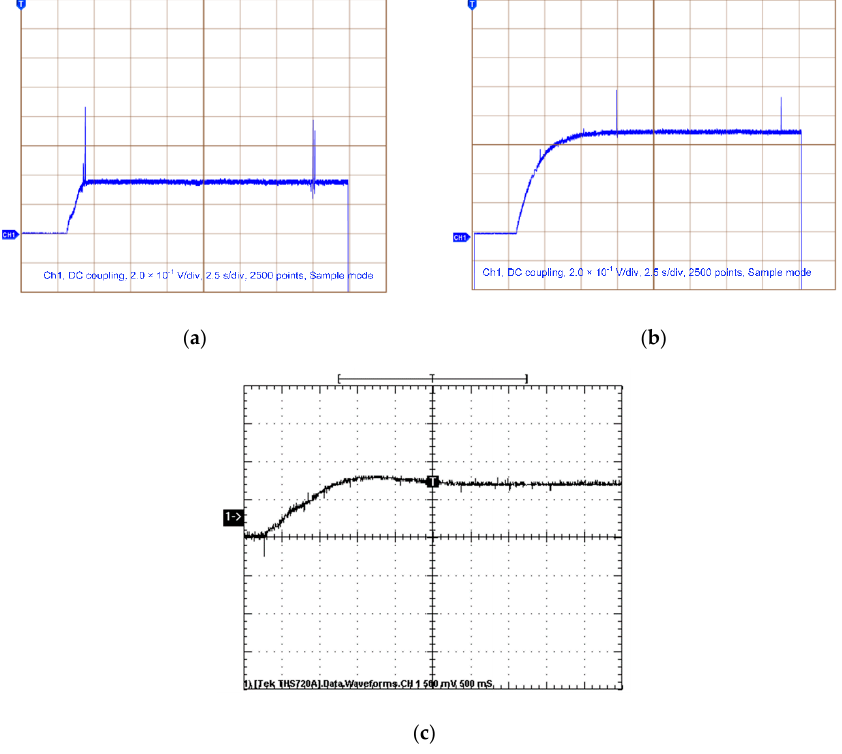
Figure 19. Curves of the tested rotor speed: ( a ) the given rotor speed is n = 400 rpm, and the load is T = 0.05 Nm (ordinate: 230 rpm/div., abscissa: 2.5 s/div.); ( b ) n = 800r/min and T = 0.05 Nm (ordinate: 230 rpm/div., abscissa: 2.5 s/div.); ( c ) n = 800r/min and T = 0.50 Nm (ordinate: 570 rpm/div., abscissa: 0.5 s/div.). Table 3. Comparison simulated and tested rotor speed curves.